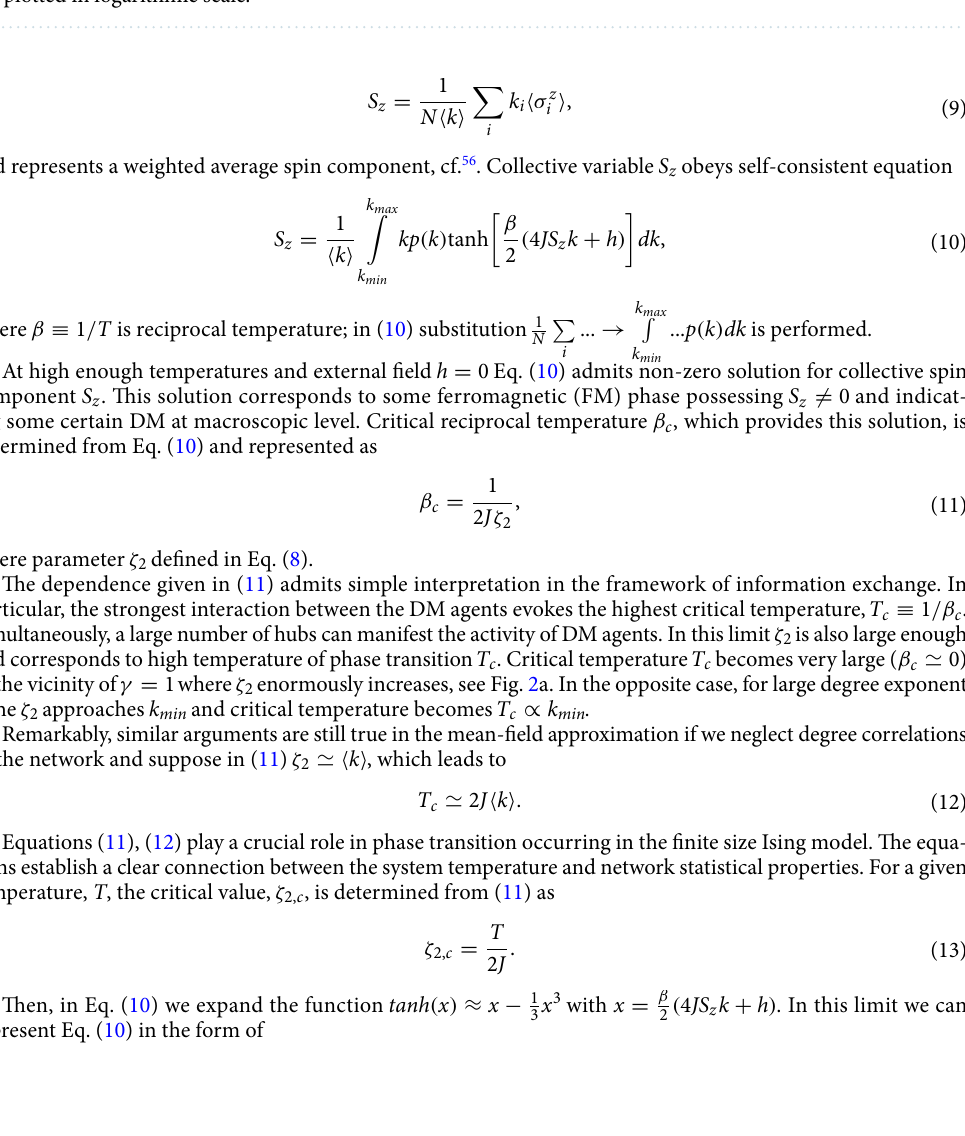
ζ 2 , ζ 31 ζ 3 and ζ 41 k , ζ 21 ≡ ≡ (cid:31) (cid:30) k (solid lines) on N for k min (cid:31) (cid:30)